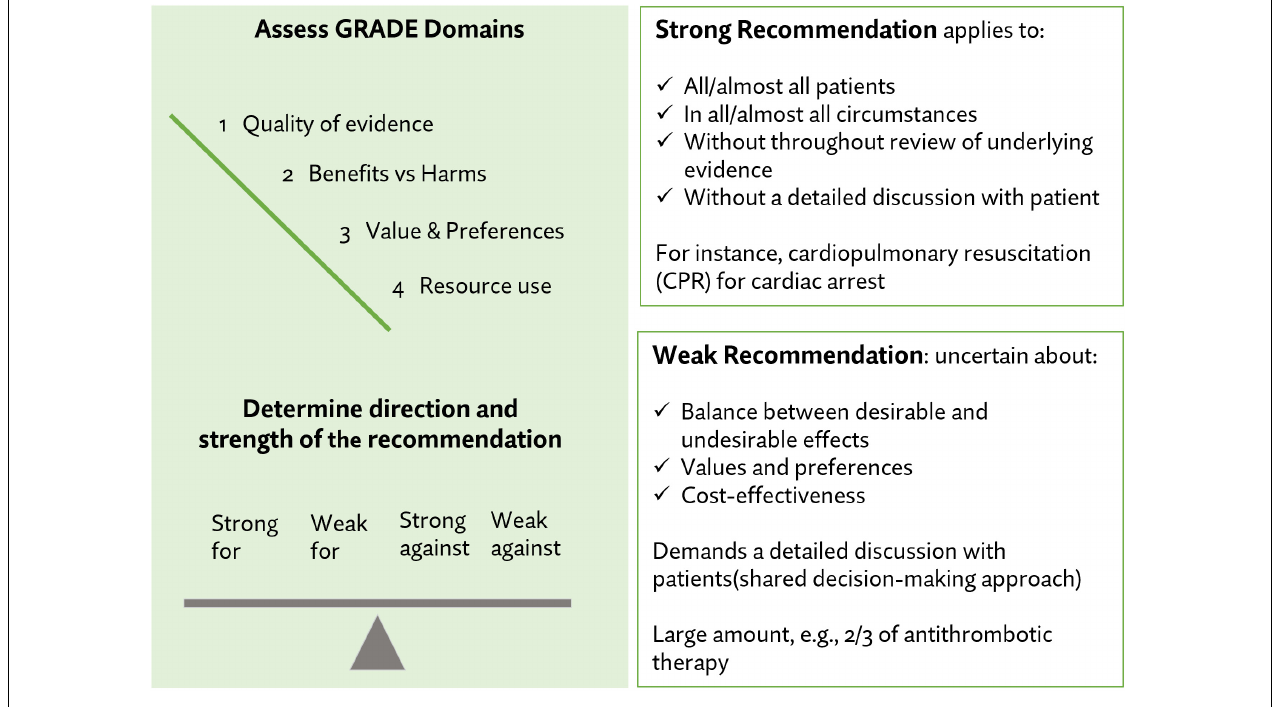
FIGURE 1 | Strength and quality assessments for individual